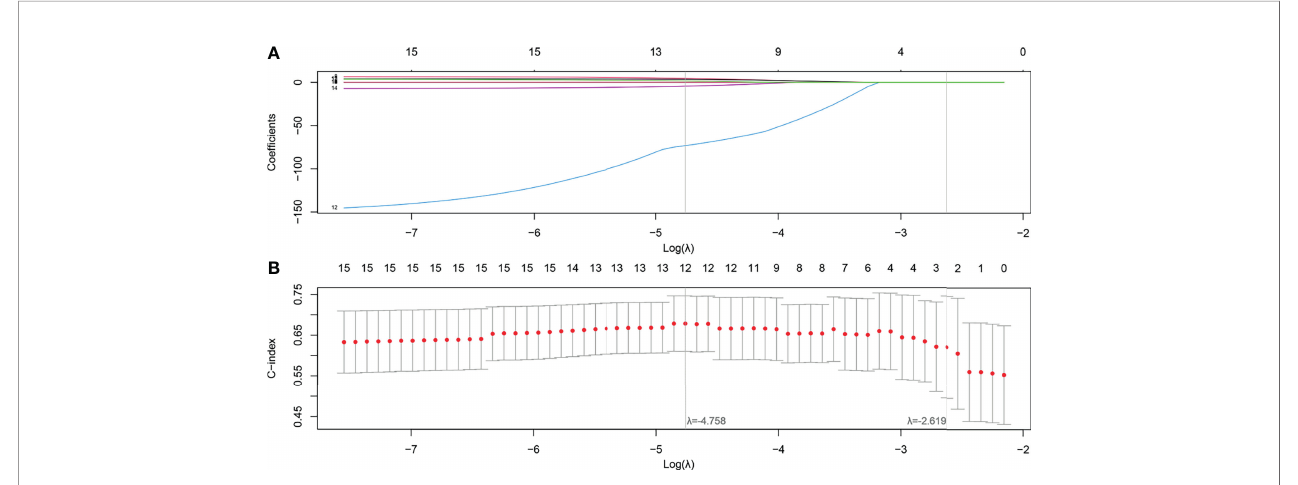
FIGURE 3 | Feature selection using the least absolute shrinkage and selection operator (LASSO) with a Cox regression model. (A) Plot of the LASSO coef fi cient vs. log ( l ). (B) Plot of the tuning parameter vs. log( l ). The C-indices are depicted with the corresponding l . Vertical lines are maximum and 1 − standard criteria,